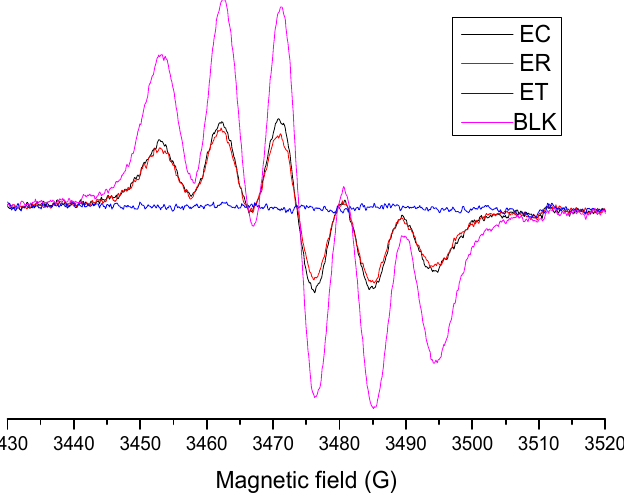
Figure 5. DPPH radical quenching of Argylia ethanolic extracts obtained by EPR analysis.